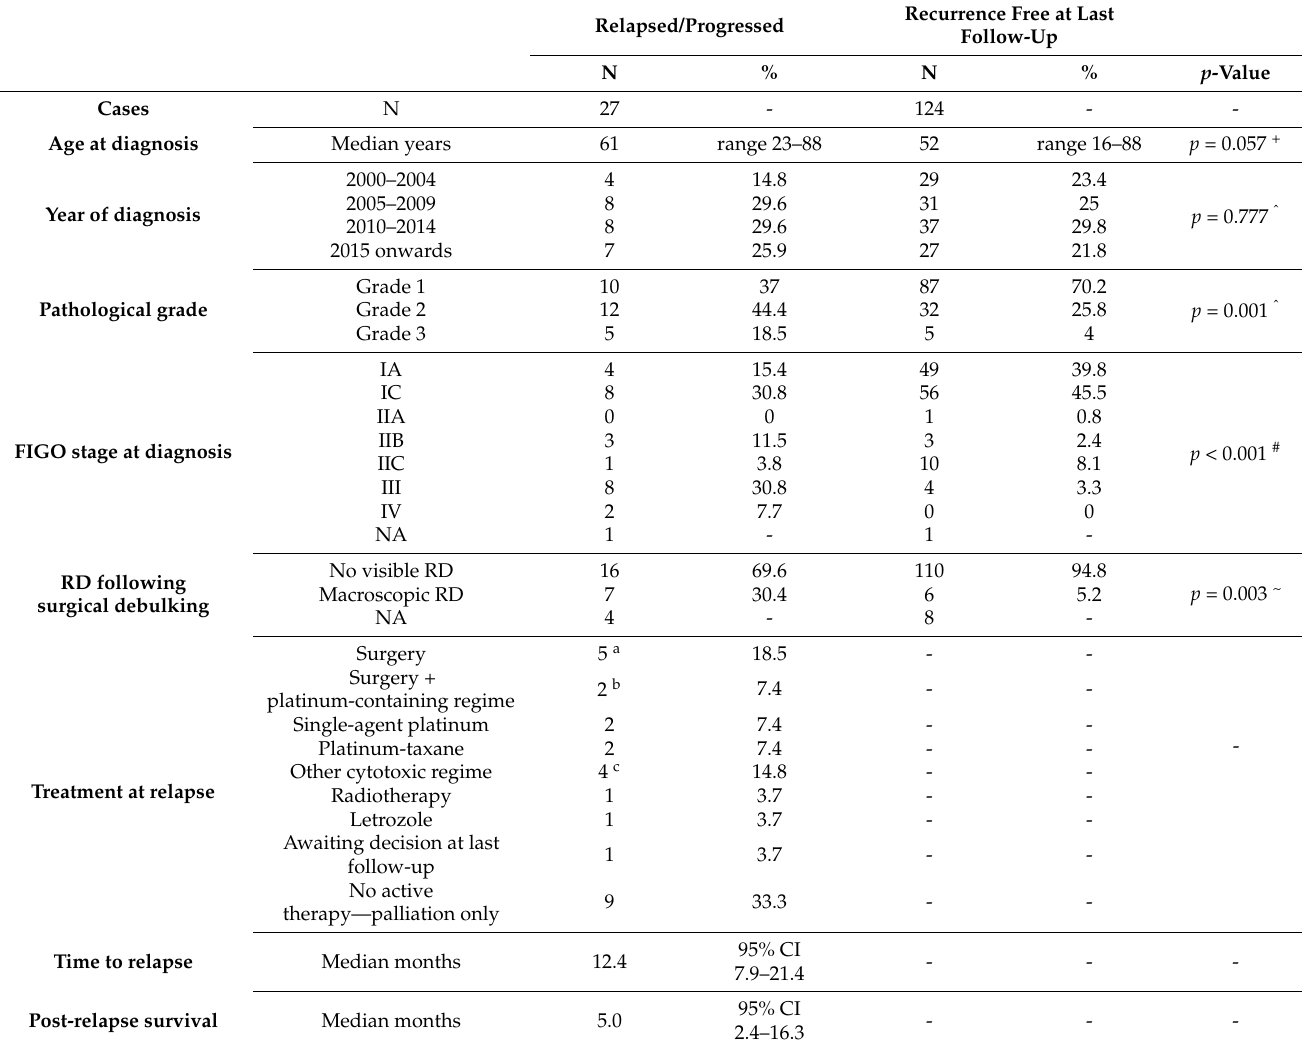
Table 3. Characteristics of relapsed and relapse-free mucinous ovarian carcinoma.